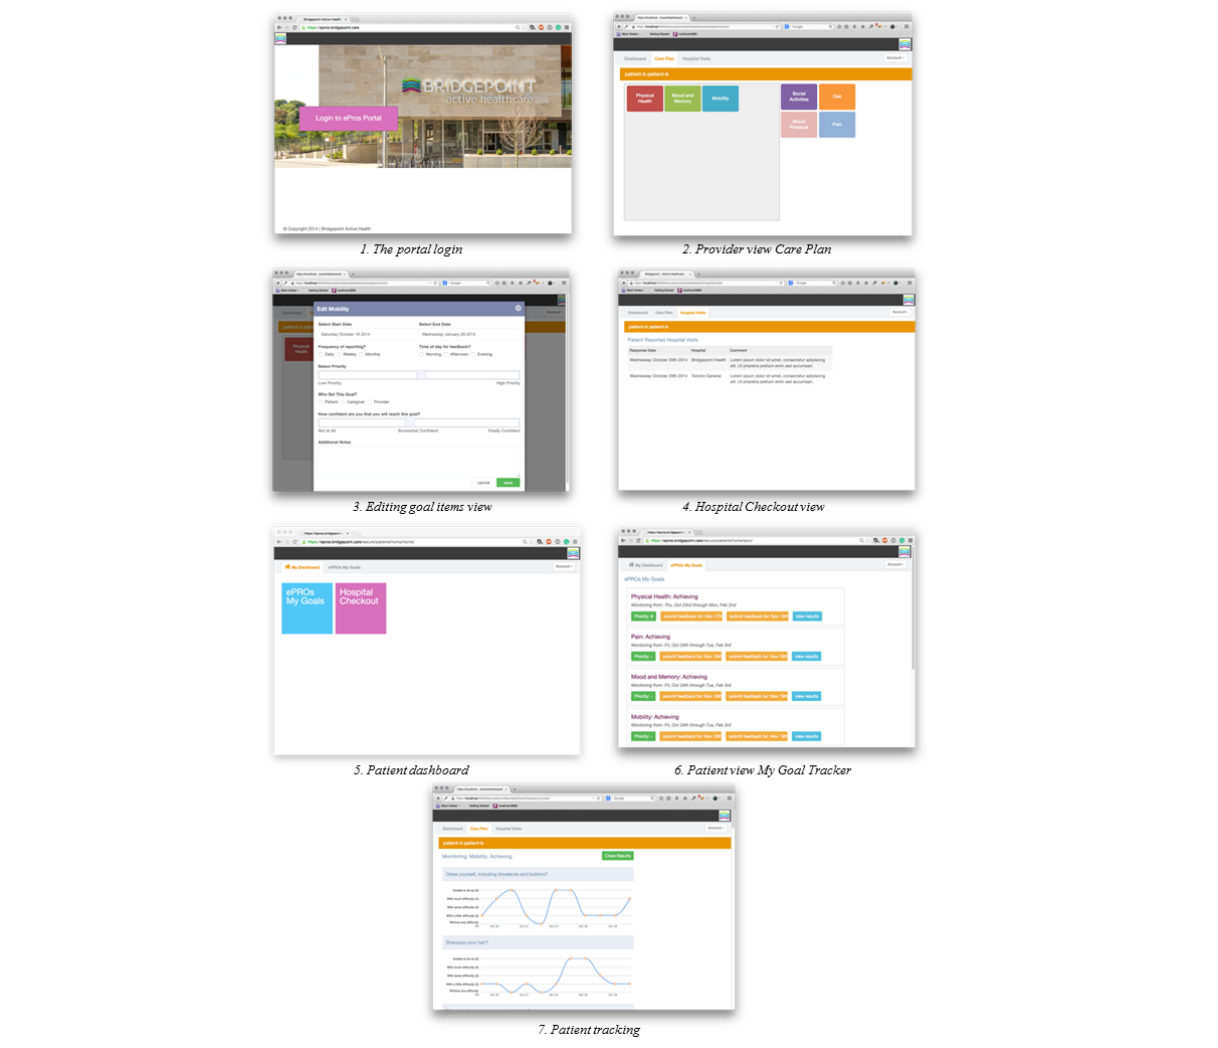
Figure 2. Depiction of the ePRO